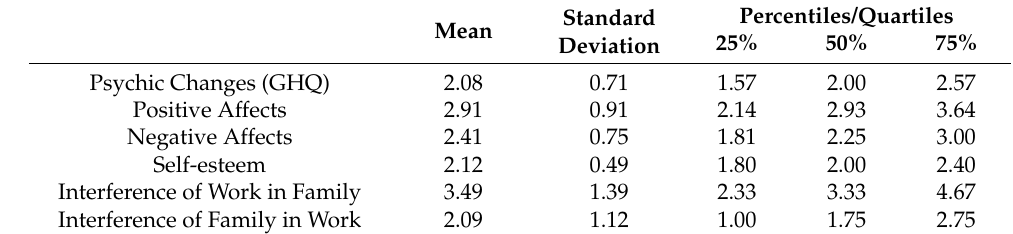
Table 2. Participants’ scores by the indicators of mental health ( n = 285).